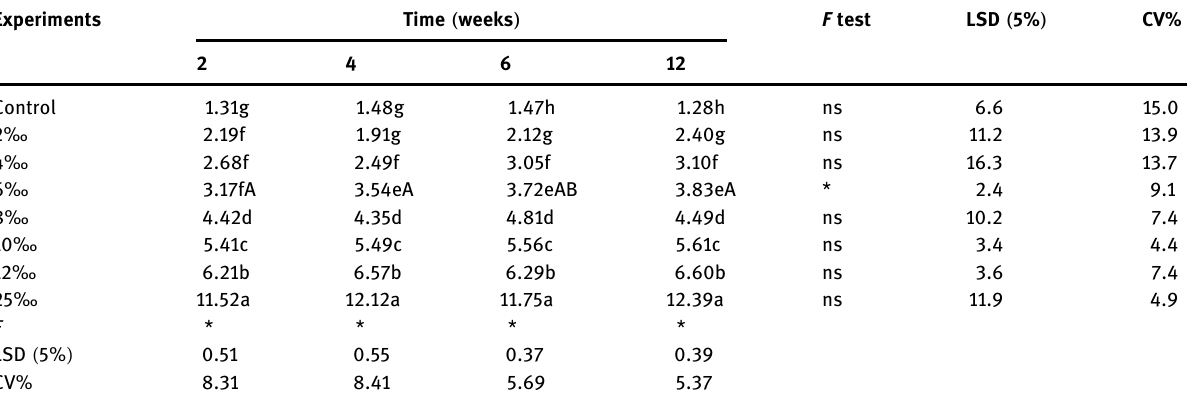
Table 5: The EC ( 1:2.5 ) change in soil according to salinity and salinity duration Experiments